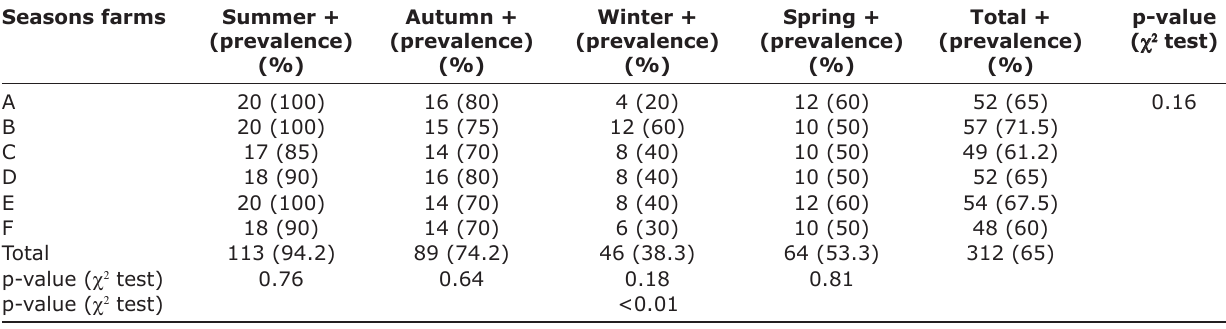
Table-2: Effect of seasonal variations on the prevalence of thermotolerant Campylobacter in broiler farms. Seasons